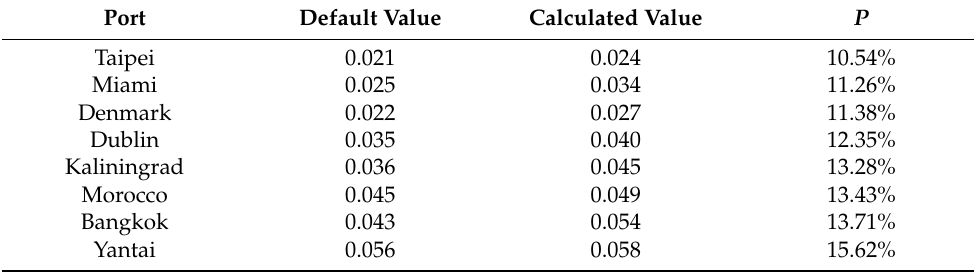
Table 4. Service capacity needs to be optimized for these ports.